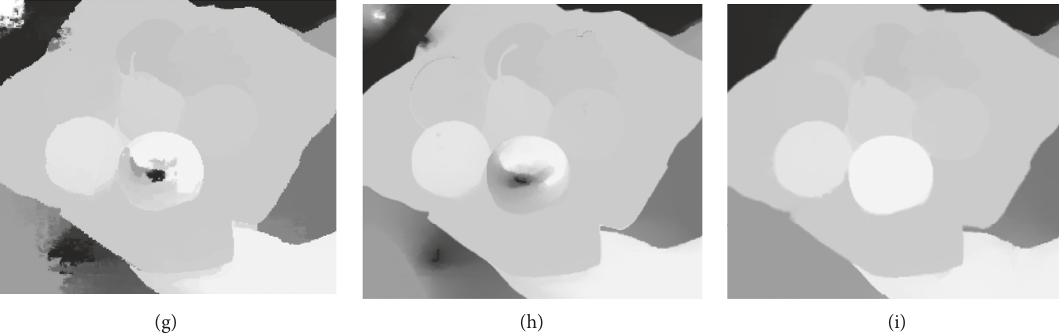
Figure 11: Results for RGBZ_07 in the presence of inaccurate scribbles. (a) Input image. (b) User scribbles. (c) Groundtruth. (d) Depth of